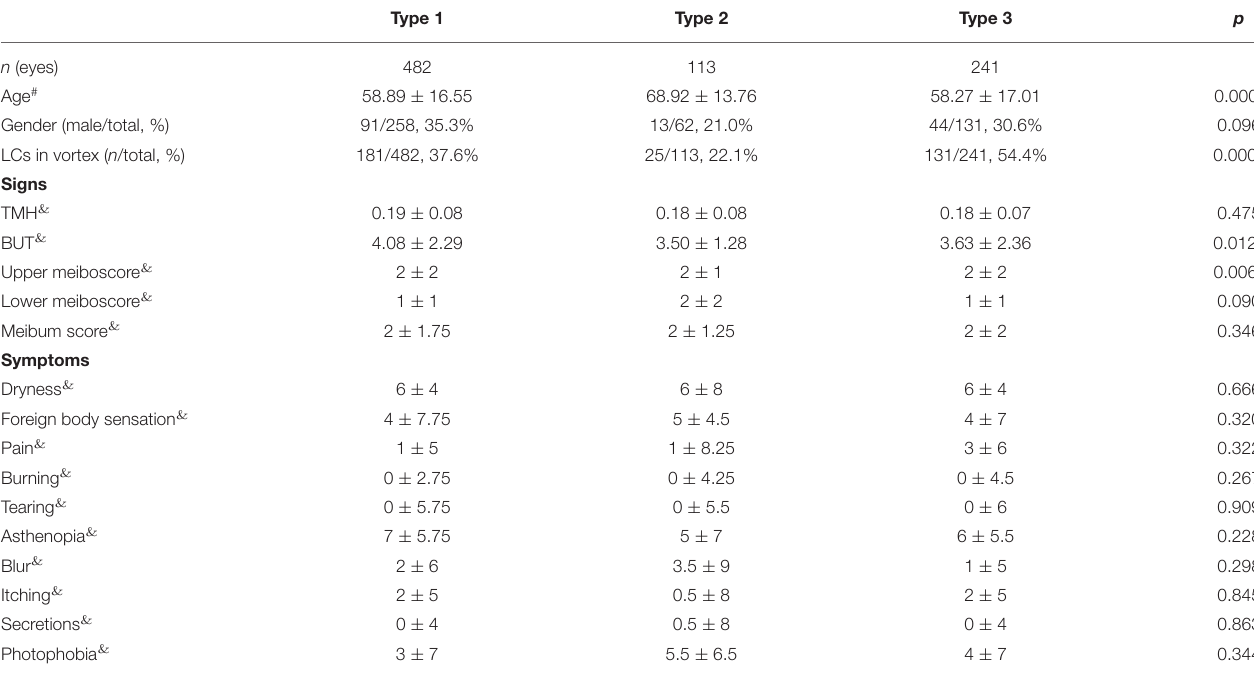
TABLE 4 | The demographics, ocular surface signs and symptom comparisons of the type 1 group, type 2 group, and type 3 group.